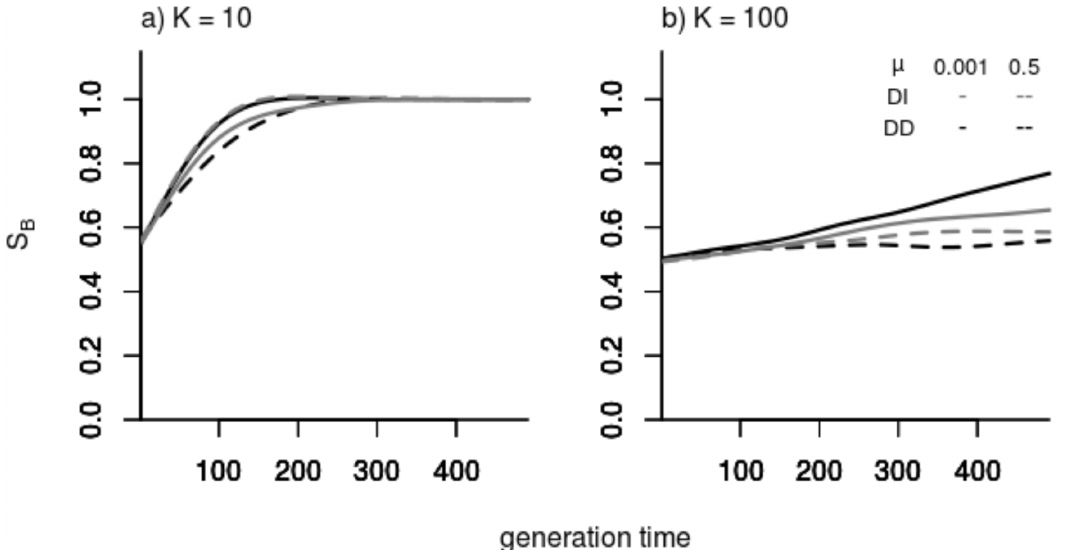
Fig 5. Exemplary change in the proportion (S B /(S B +S N )) of individuals with the breeding dispersal strategy over time during evolutionary tournaments. (a) Scenario with small patch size ( K = 10) and (b) scenarios with large patch size ( K = 100); environmental variability σ = K in all cases. Black and grey lines represent density-dependent ( DD ) and density-independent ( DI ) emigration scenarios, full and dashed lines represent mortalities μ = 0.001 and 0.5, respectively.